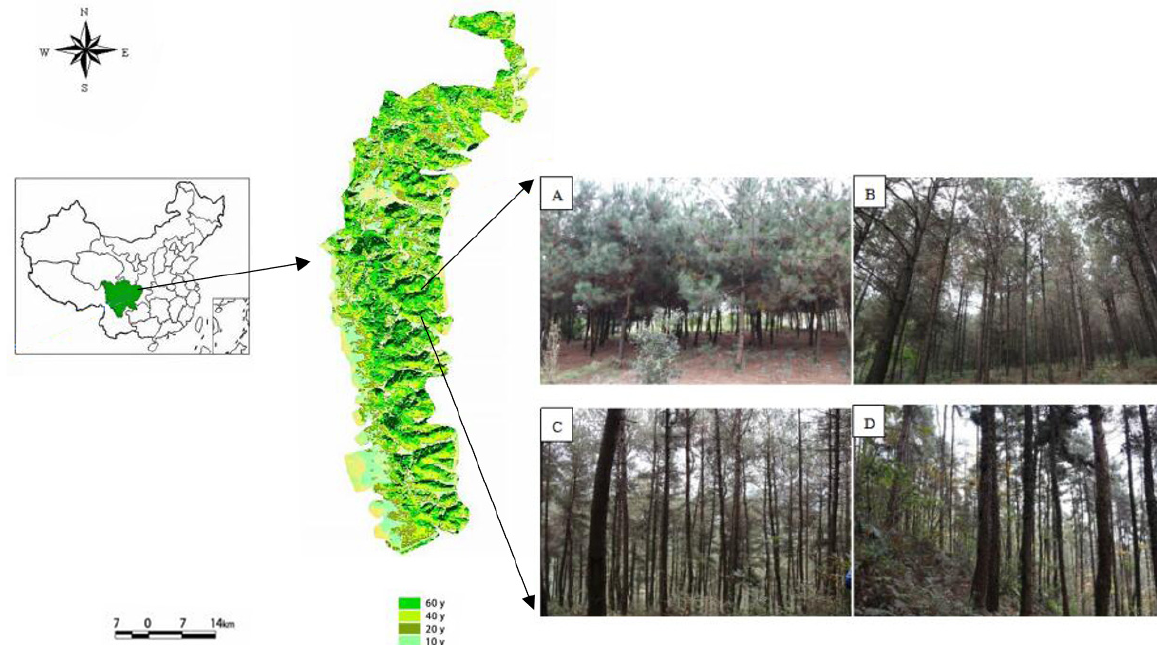
Figure 1. Test plot (the study area is located in Southwest China; 10 years, 20 years, 40 years, and 60 years represent a Masson Pine forest age of 10, 20, 40, and 60 years old, respectively; ( A – D ) are the respective 10, 20, 40, and 60-year-old Masson pine plantations).